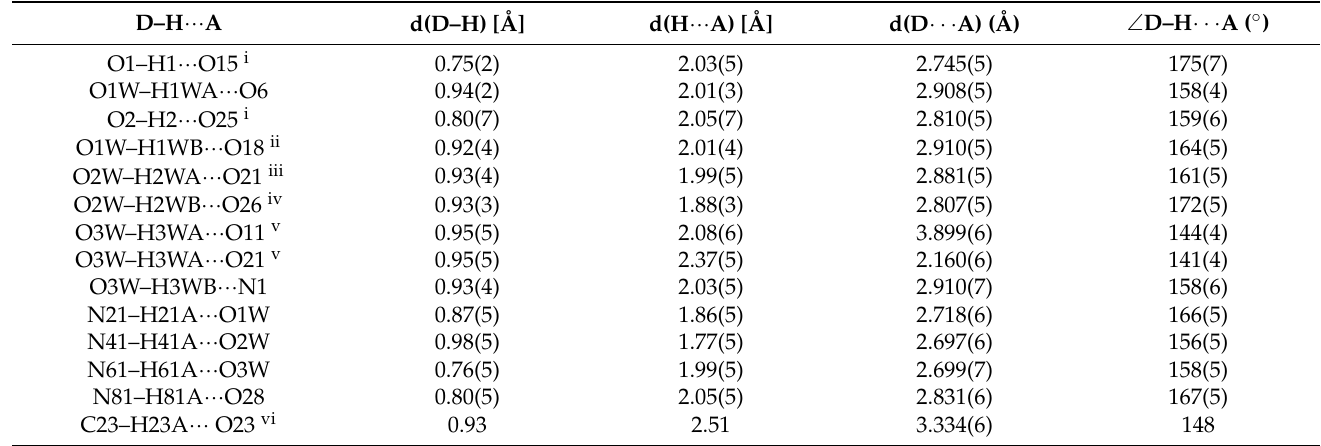
Figure 1. Molecular structure of title compound, showing the atom-labelling scheme. Table 2. Hydrogen bond geometry for the title